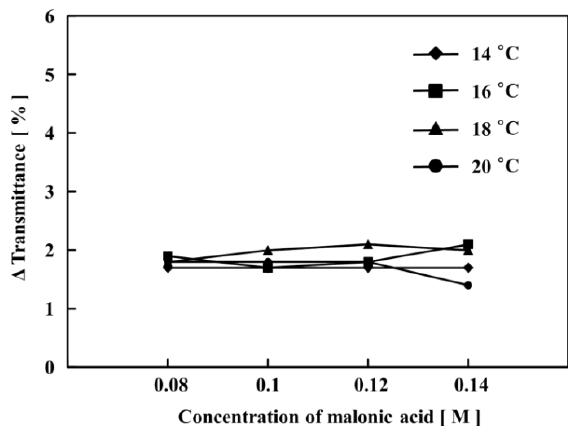
Figure 14. Dependence of the amplitude of the transmittance self-oscillation for the poly(AM- co -Ru(bpy) ) solutions on changes in the concentration of one BZ substrate 3 ([MA] = 0.08, 0.1, 0.12 and 0.14 M) at fixed concentrations of the other two BZ substrates ([NaBrO ] = 0.3 M and [HNO ] = 0.3 M) at different constant temperatures ( T = 14, 16, 3 3 18, and 20 °C).